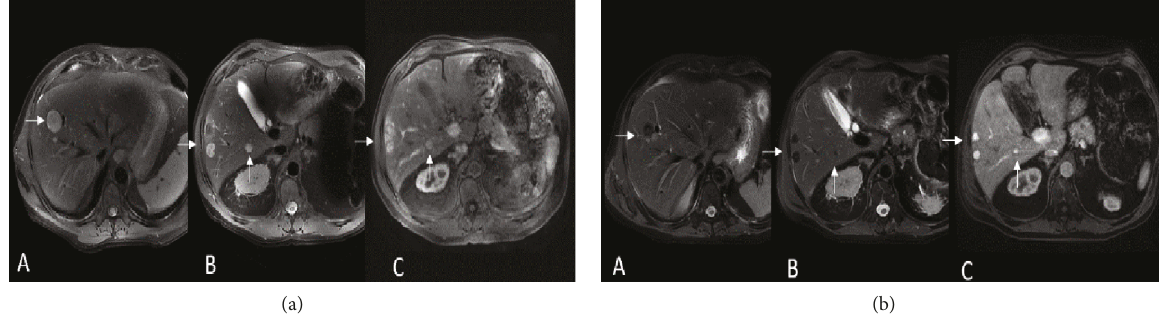
Figure 3: (a) Pretreatment scans (MRI). Axial T2 WI (A, B) and postcontrast (Eovist) Axial T1 WI (C) show multiple metastatic lesions (arrows) in both liver lobes. (b) Posttreatment scans (MRI). Axial T2 WI (A, B) and postcontrast (Eovist) Axial T1 WI (C) show the decrease in size and number of multiple lesions (arrows) in both liver